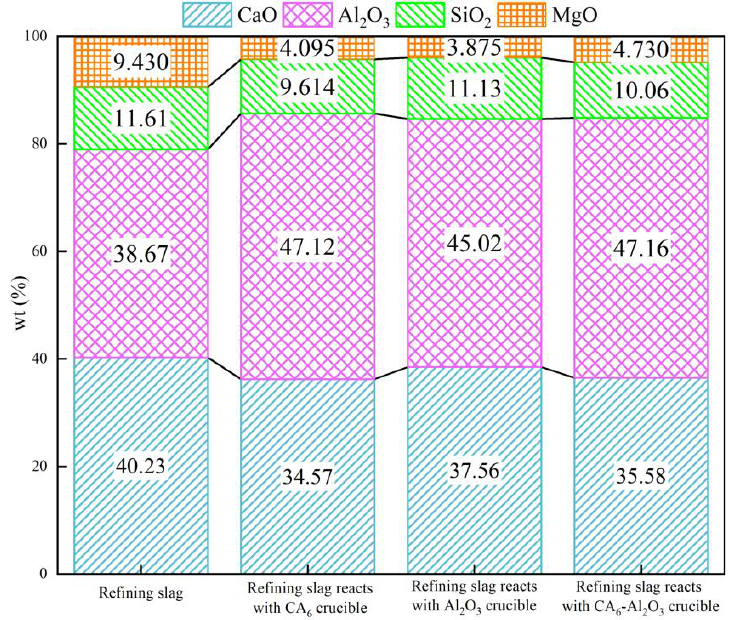
Figure 2. Composition variation of the refining slag.